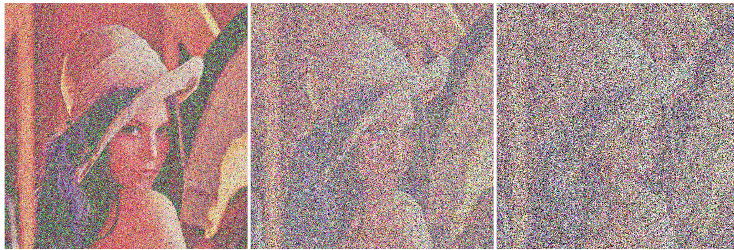
Figure 13. Decrypted images of cipher images cut in varying degrees.